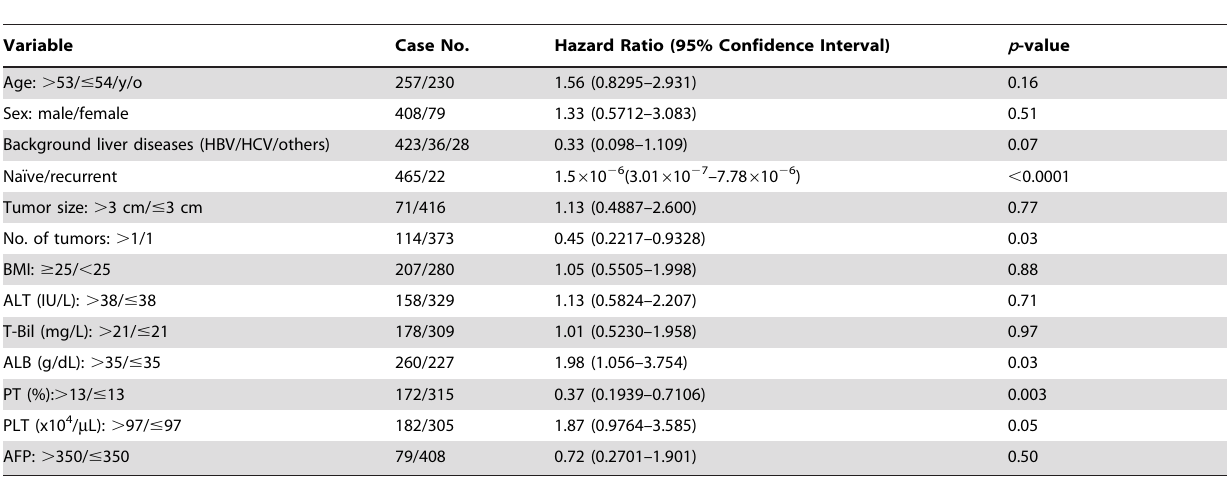
Table 2. Factors associated with poor overall survival after RFA and TACE for HCC by univariate analysis.